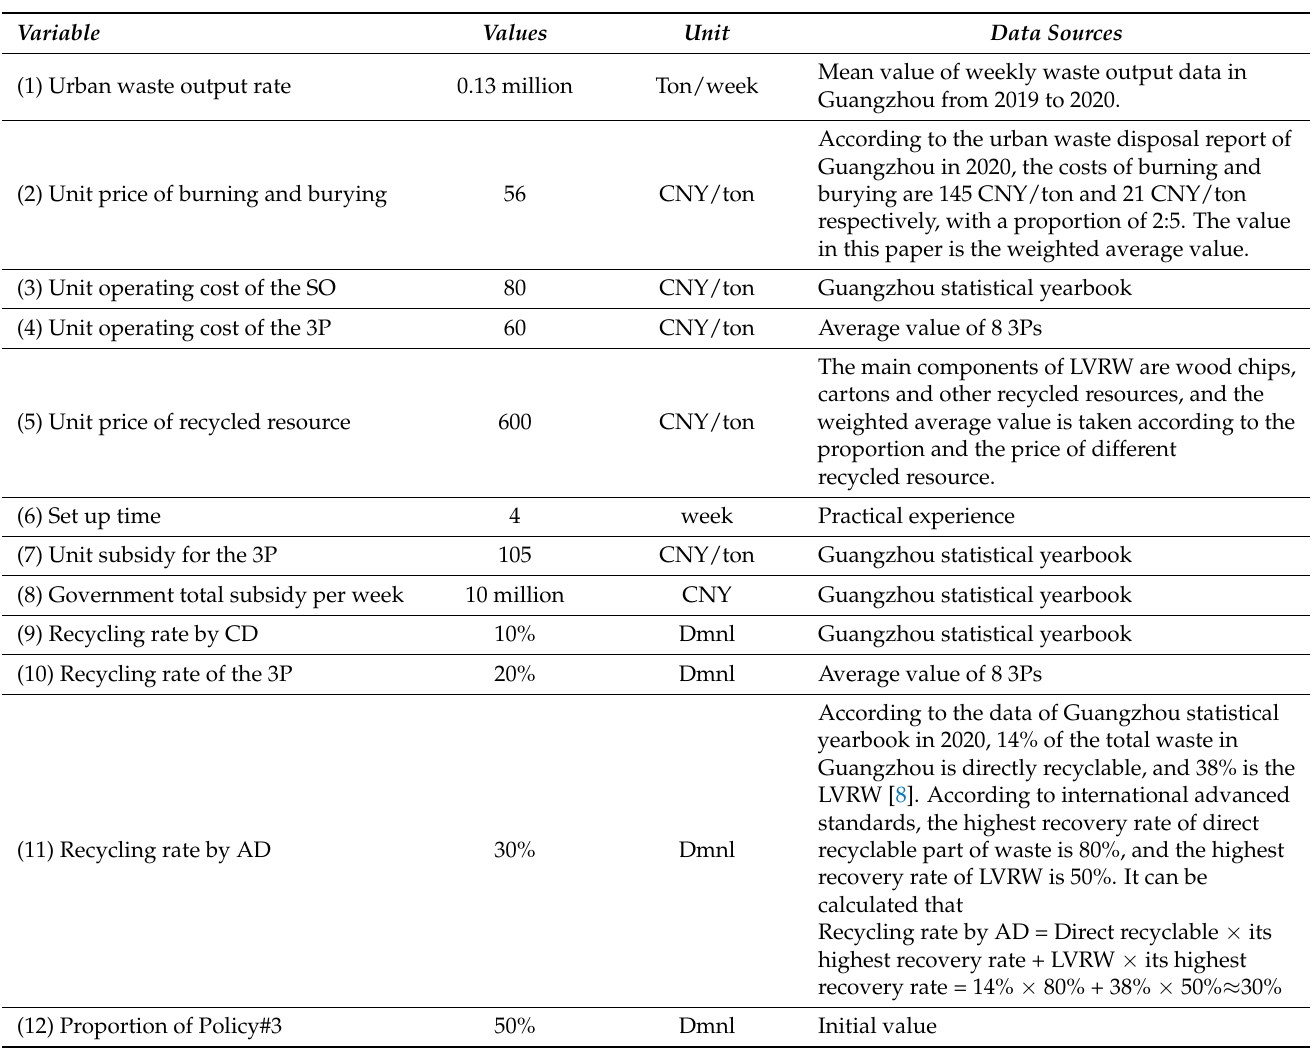
Table 7. Data sources.